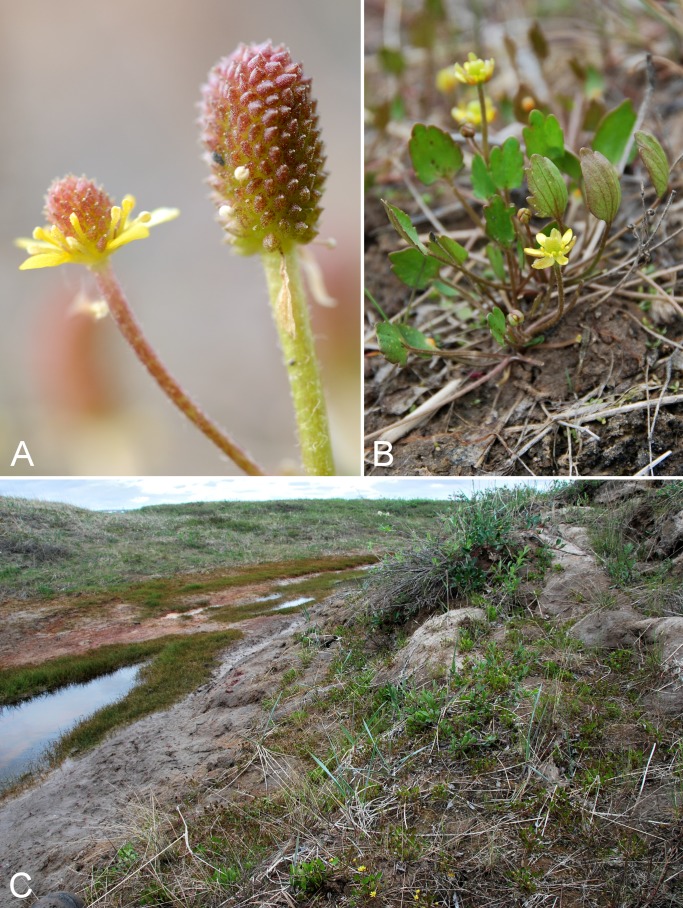
Halerpestes cymbalaria.(A) Inflorescence and developing fruits, Saarela et al. 4325. (B) Habit, Saarela et al. 3669. (C) Habitat, Saarela et al. 3669. Photographs by R. D. Bull (A) and J. M. Saarela (B, C).